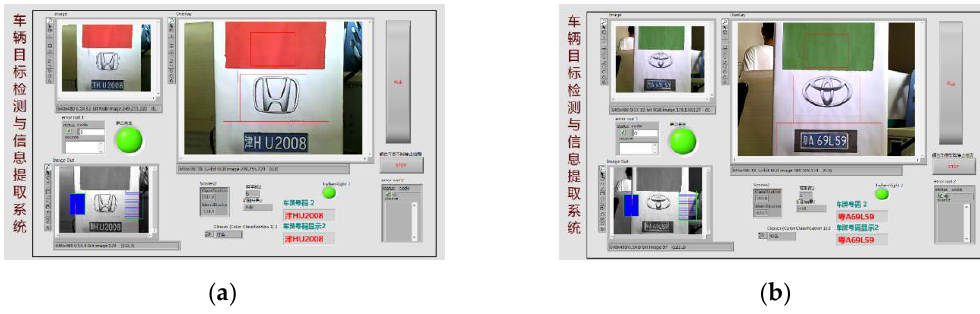
Figure 26. Overall system recognition results: ( a ) Vehicle 1 and ( b ) Vehicle 2.